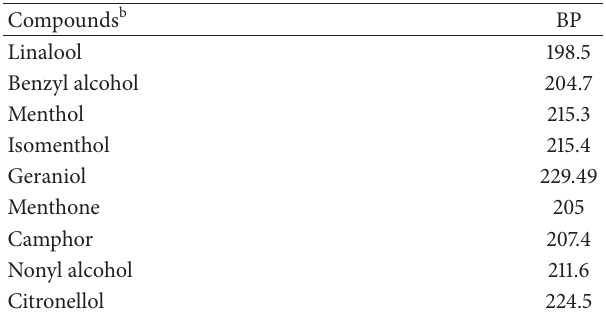
Table 2: Calculated molecular descriptors a for alcohol and ketone compounds used in QSAR analysis of the ovicidal activity against Pediculus humanus capitis